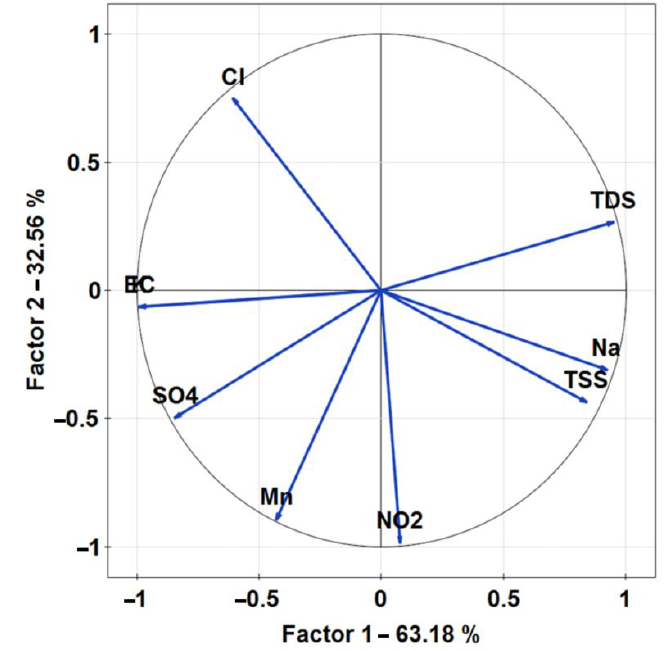
Figure 12. Projected data for physicochemical properties of stream in studied urban area using PCA.